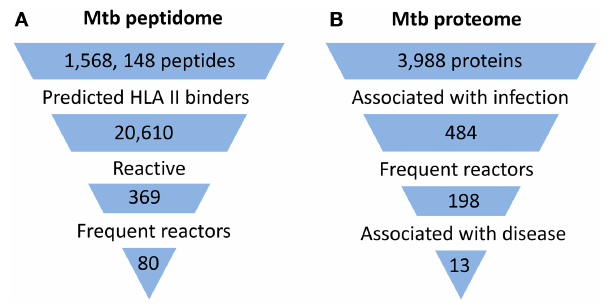
FIGURE 1 | Summary of proteome-wide screens for Mtb antigens . (A) Summary of screen for targets of CD4 + T cells (8). Mtb peptide sequences that represented 5 complete and 16 incomplete Mtb genomes were analyzed by HLA Class II consensus prediction method for binding to 22 of the most commonly expressed alleles of HLA-DR, -DP, and -DQ sequences. Peptides predicted to bind with high affinity were synthesized and tested by ELISPOT for stimulation of IFN γ production by circulatingT cells of 28 latently infected, non-BCG vaccinated donors from a non-endemic area. Among the 369 reactive peptides, 80 peptides accounted for 75% of the total response. (B) Summary of one of two published screens for targets of humoral responses (11). Approximately 95% of the open reading frames of Mtb (H37Rv strain) corresponding to 3,988 proteins were cloned and expressed in vitro in an Escherichia coli -based cell-free transcription/translation system.The crude reactions containing expressed proteins were printed directly onto nitrocellulose-coated slides without purification.These slides were then probed with sera from uninfected healthy individuals from a non-endemic country ( n = 64) and suspected cases ofTB (TB and non-TB pulmonary patients) from endemic countries ( n = 561).The proteins that reacted to sera from endemic countries but not to sera of uninfected individuals were defined as antigens associated with infection. Among 484 such antigens, 198 reacted to more than one serum from endemic countries and were designated frequent reactors. Proteins associated with disease were identified by comparing responses inTB patients and non-TB